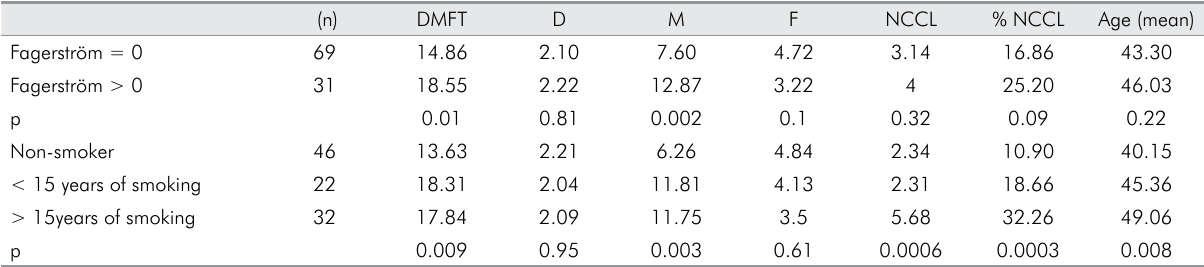
Table 6. Association of tobacco use with DMFT and NCCLs.